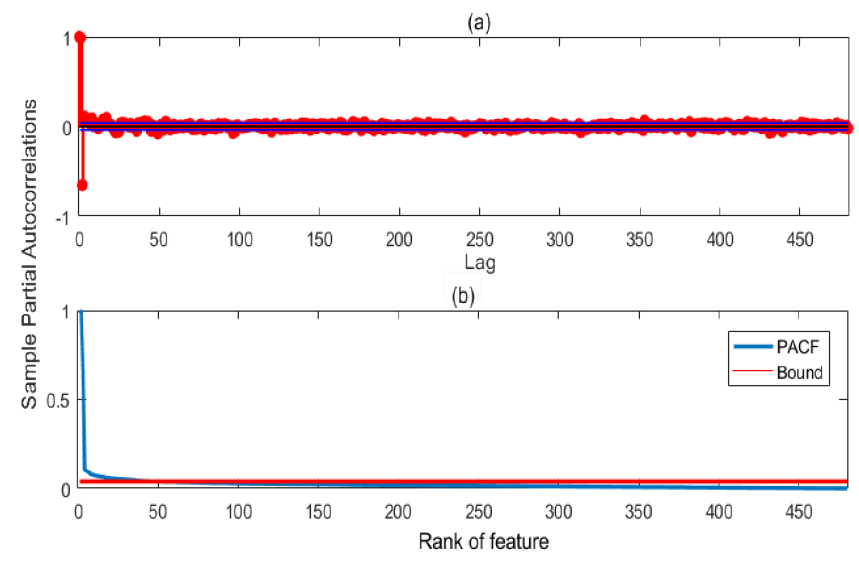
Figure 5. PACF for each time lag variable and ranked PACF in Yibin. ( a ): PACF for each time lag variable; ( b ): ranked PACF. Its understanding is similar to Figure 3.